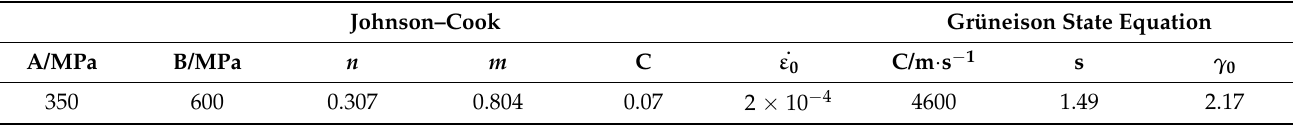
Table 2. Constitutive parameter values of 45 steel cylindrical shell [38].